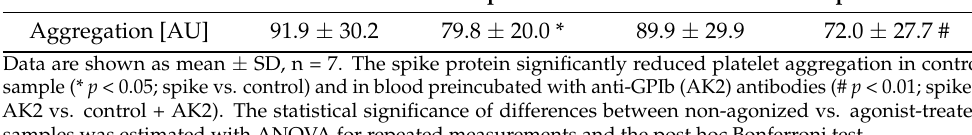
Table 3. The influence of spike protein on collagen-induced whole blood platelet aggregation in the presence of anti-GPIb (AK2) antibodies.